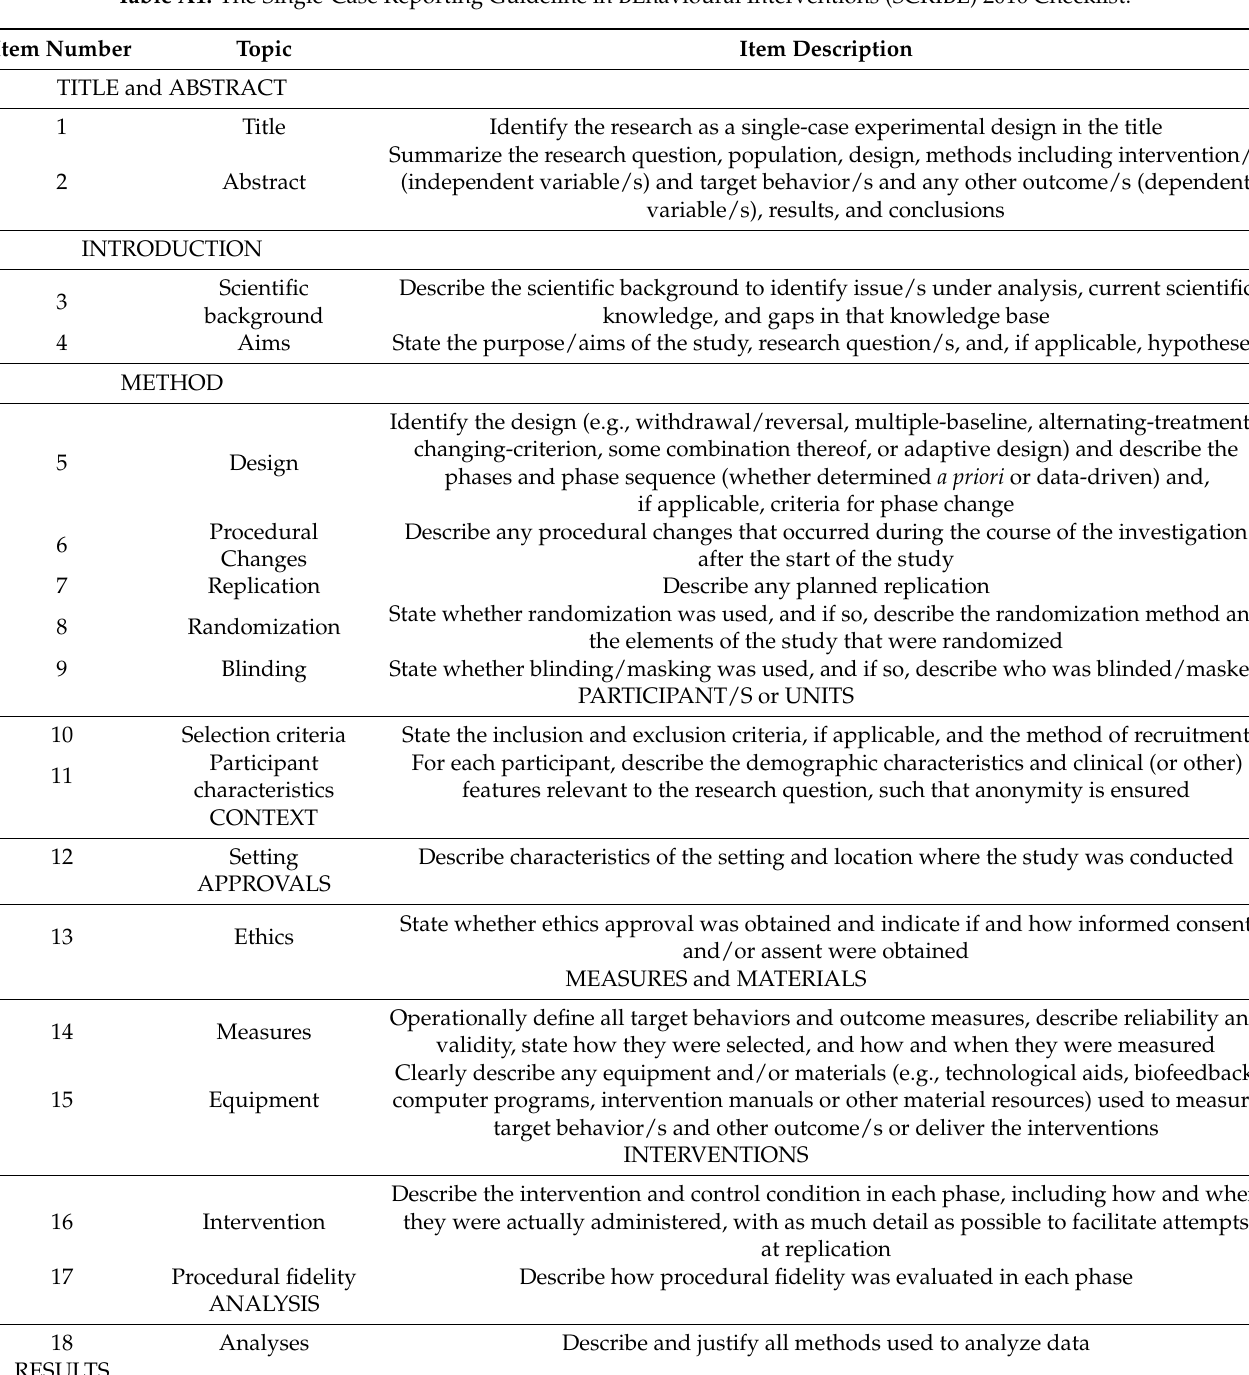
Table A1. The Single-Case Reporting Guideline in BEhavioural Interventions (SCRIBE) 2016